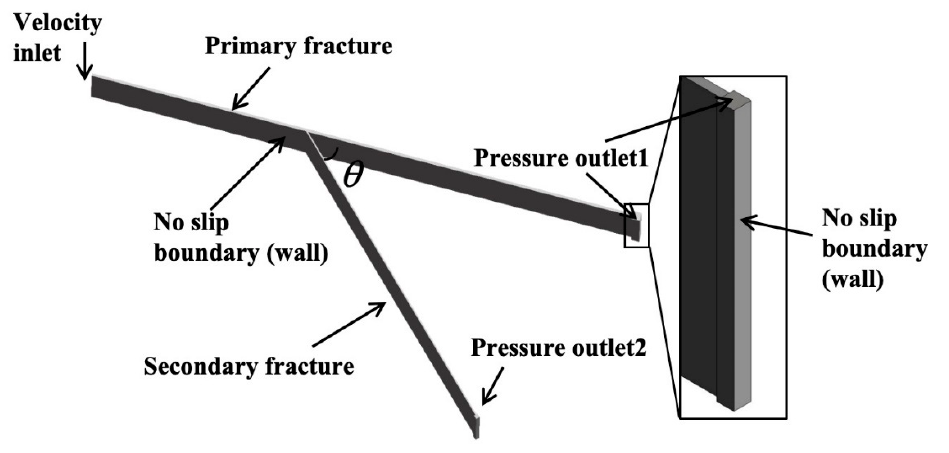
Figure 1. The geometry representing the cross fractures. The cross fractures consist of a primary fracture and a secondary fracture in length × height: 1000 mm × 150 mm and 600 mm × 150 mm, respectively. The width and the bypass angle will be changed in different cases.